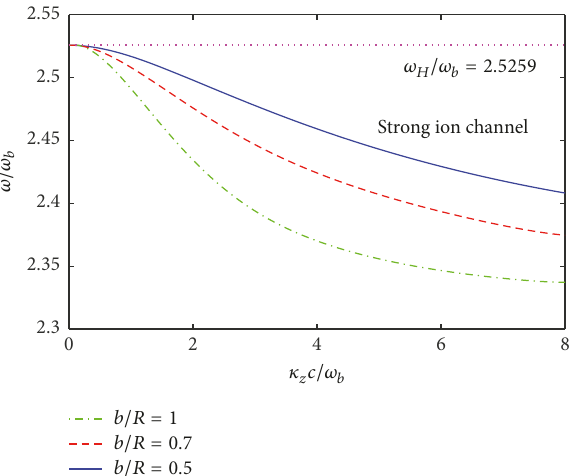
Figure 3: The influence of the ratio 𝑎/𝑏 on the dispersion curves of the Be 01 waves for strong ion channel with 𝜔 𝛽 = 2.3195 . The outer radius of the annular beam is taken as 0.5 R and 𝑎/𝑏 = 0 represents the solid beam case.